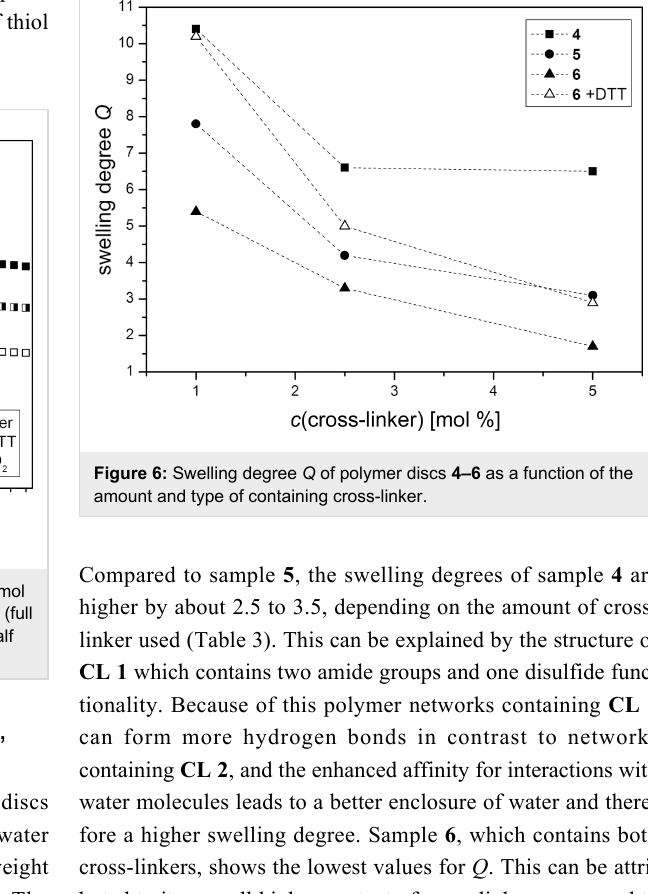
Table 3: Results for the determination of swelling degree Q and glass transition temperature T g for samples 3–6 . sample